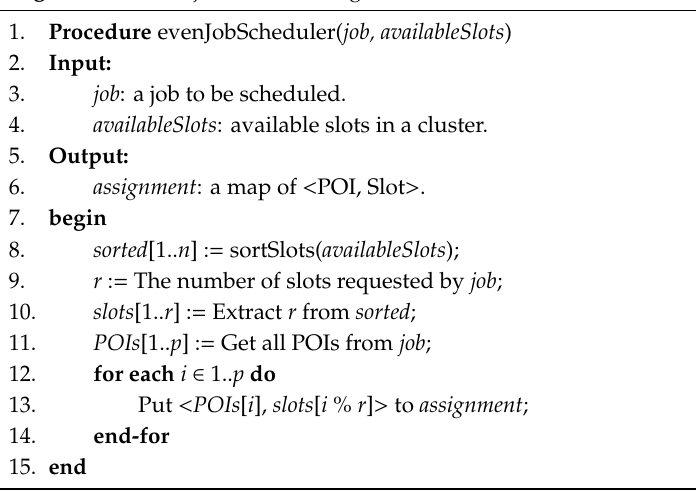
Algorithm 2 Even job scheduler